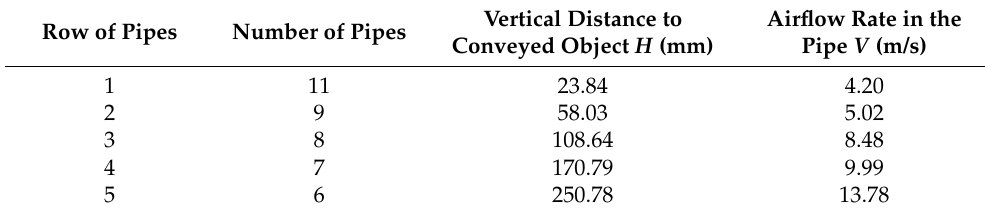
Figure 8. Calculation flow chart of the pipeline parameters of each row. Table 4. Overall piping